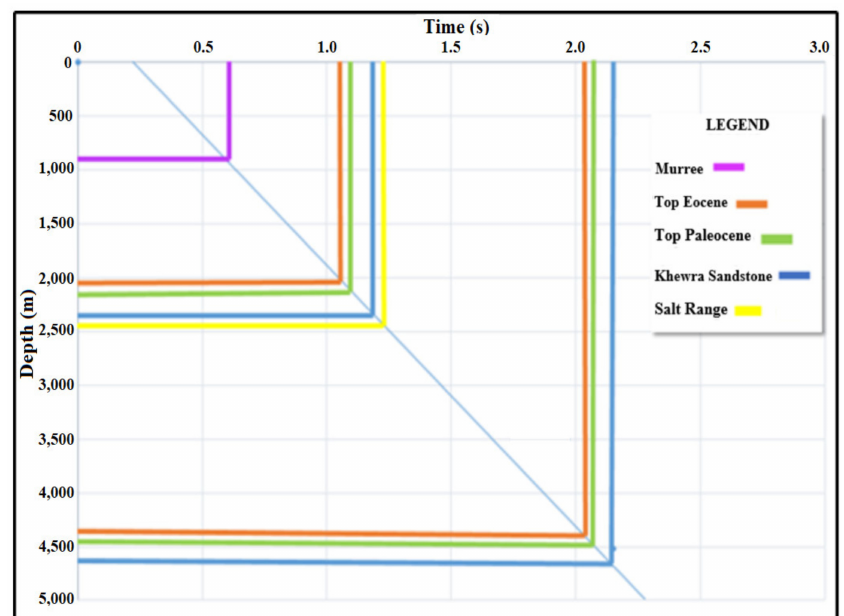
Figure 4. Time depth (TD)